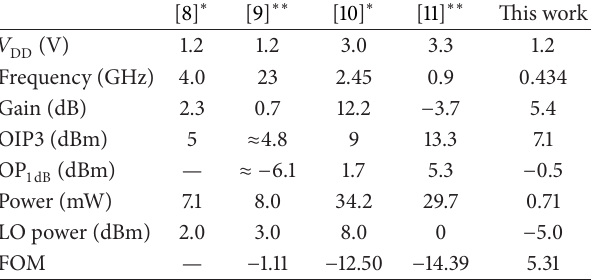
Table 2: Performance